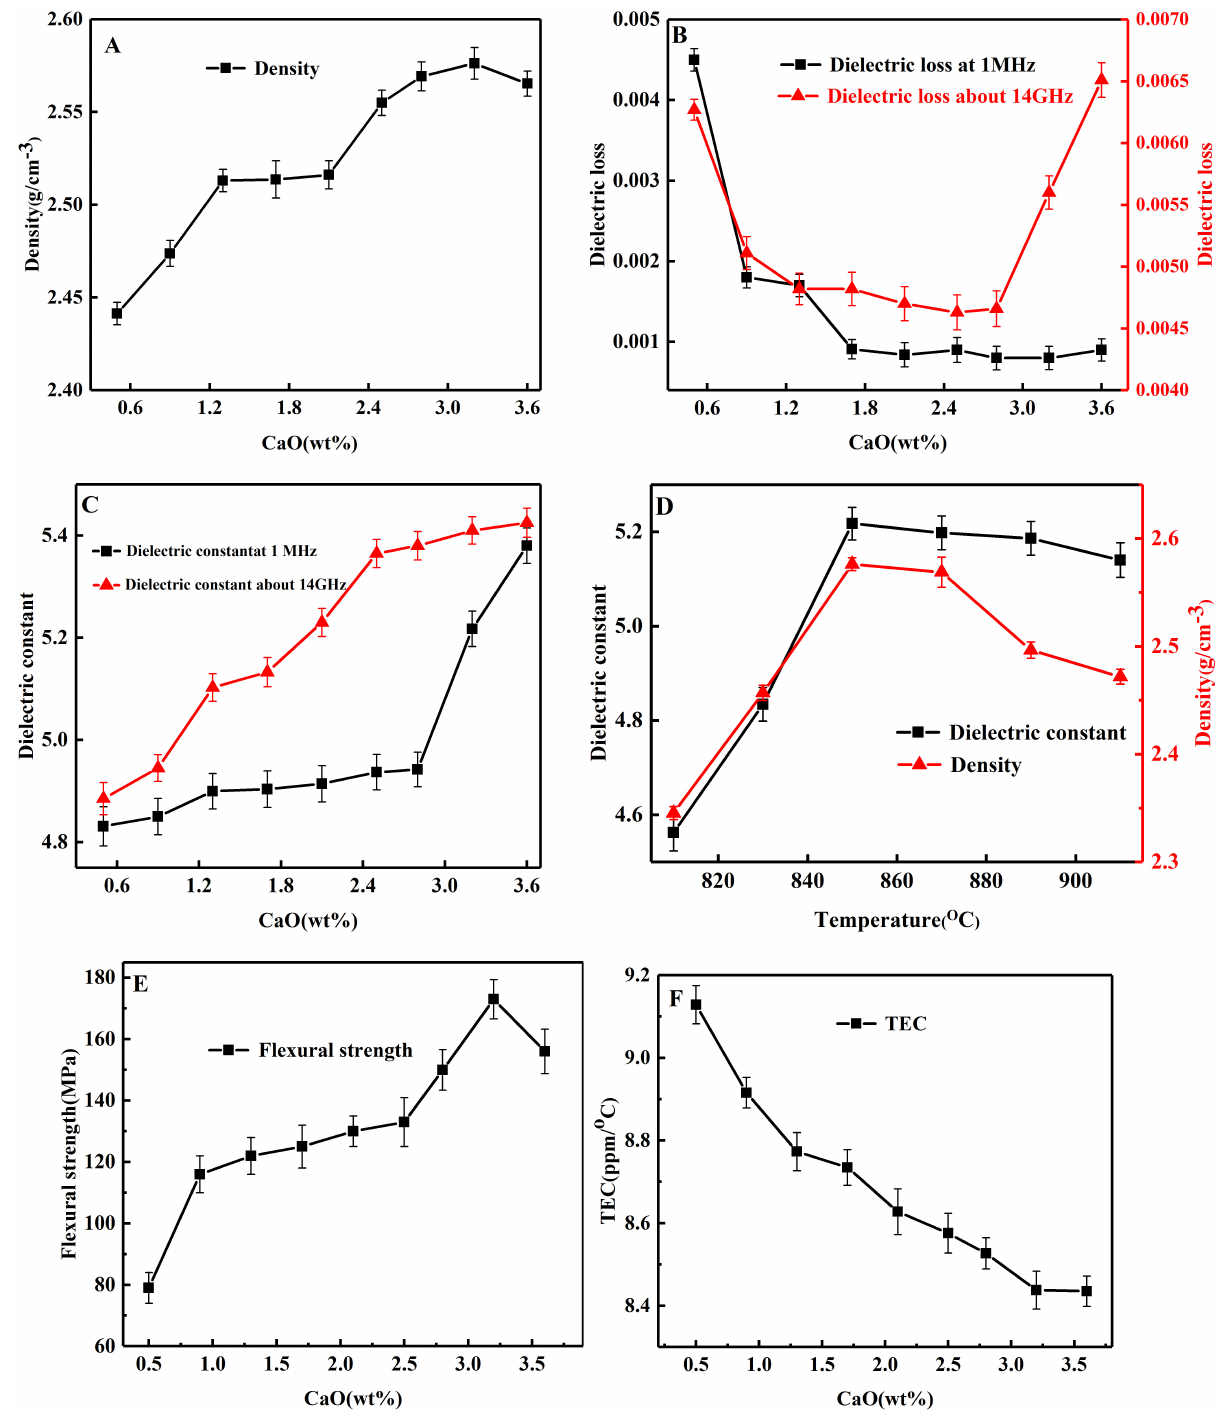
Figure 5: Properties of composites: A) density; B) dielectric loss; C) dielectric constant; D) density and dielectric constant with different temperatures; E) strength; F)